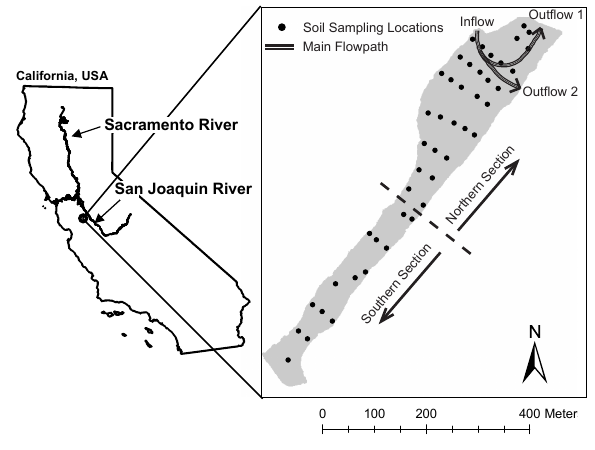
Fig. 1. Schematic of study site, sampling locations, inflow and out- flow locations, and main flow-path.